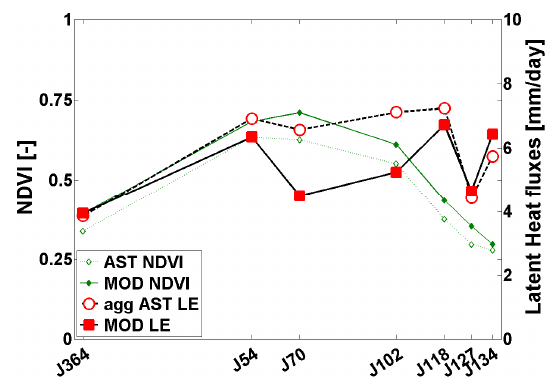
Figure 7. ‘agg-ASTER’ and MODIS SEBS latent heat flux time series.